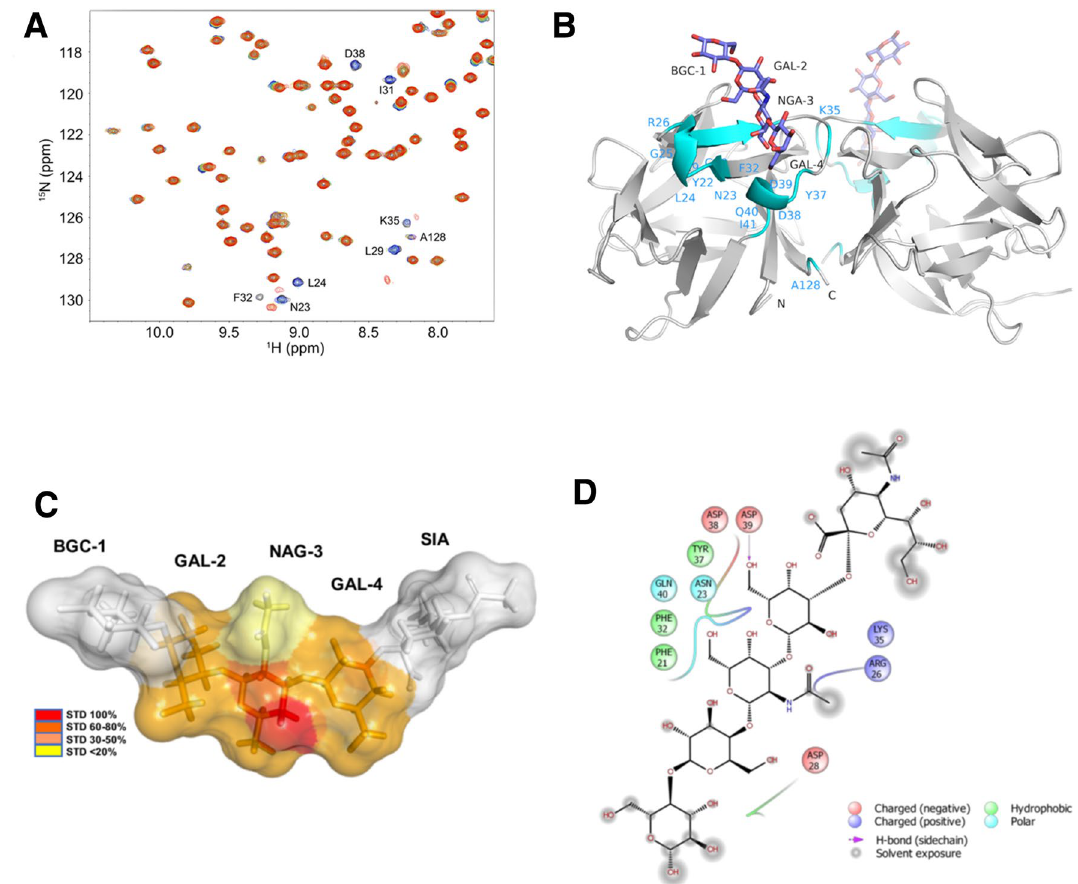
Figure 4. ( A ) Central region of the 2D 1 H- 15 N HSQC spectra of SeviL, showing residues affected by the presence of asialo-GM1. Spectra are coloured by concentration of asialo-GM1 saccharide: 0 mM (black), 0.05 mM (blue), 0.1 mM (cyan), 0.2 mM (green), 0.3 mM (yellow), 0.5 mM (orange) and 1 mM (red). ( B ) The ribbon diagram of the SeviL dimer, showing the bound saccharide. Residues showing altered HSQC signals in the presence of asialo-GM1 saccharide are coloured blue. ( C ) Epitope mapping of interactions with GM1b saccharide. The molecular model of the sugar is shown, with the van der Waals surface coloured by STD signal. The residues at each end of the saccharide showed no significant bonding with SeviL. ( D ) Diagram showing the residues surrounding the sugar ligand. The glucose (bottom left) and sialic acid (top right) residues are highly solvated and make no strong bonds with the NMR.